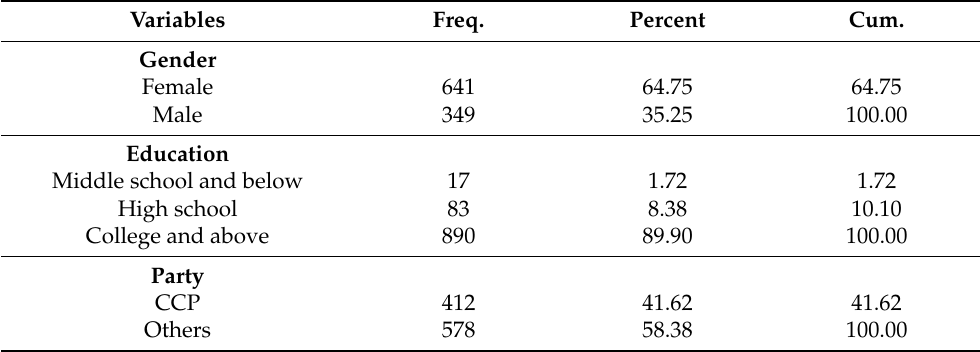
Table 2. Social background variables of the respondents